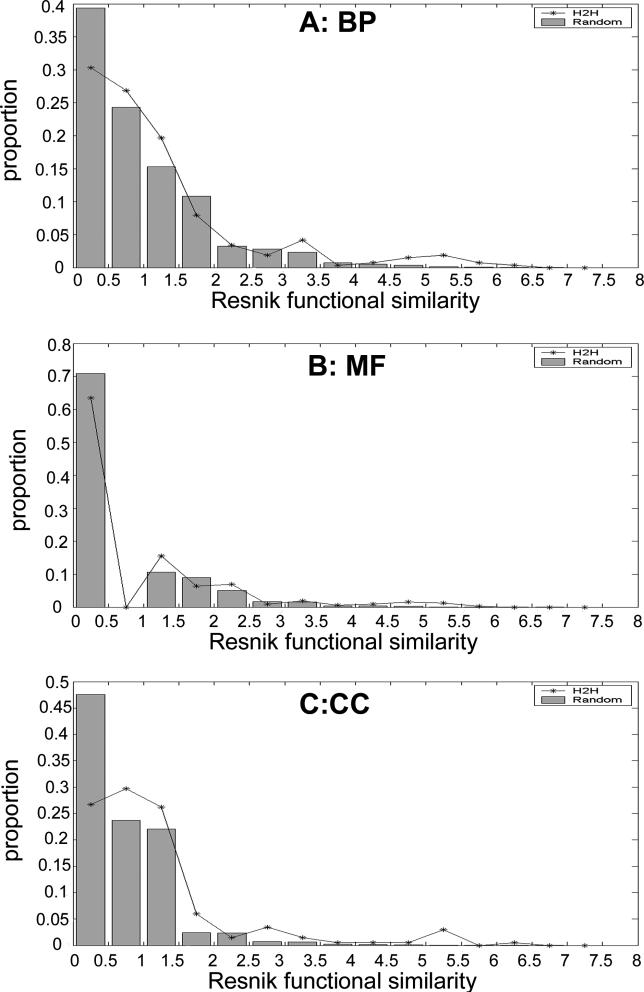
The Distribution of Functional Similarities for Head-to-Head Gene Pairs(A−C) GO subsystems “biological process,” “molecular function,” and “cellular component,” respectively.